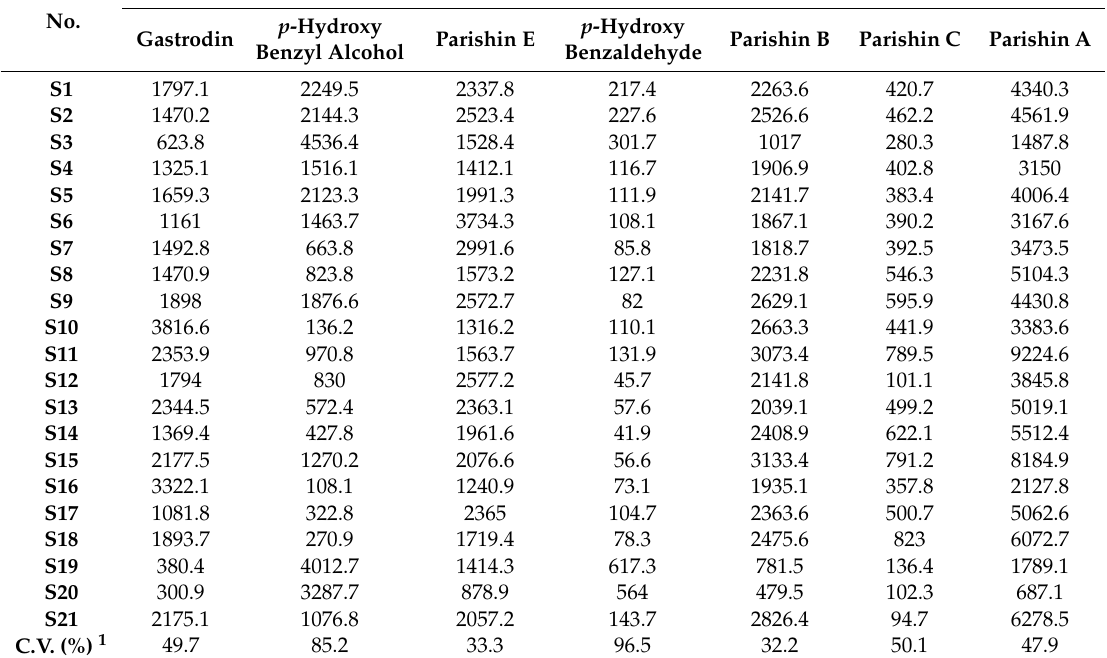
Table 3. The information and peak areas of the seven characteristic peaks in HPLC fingerprints of G. elata tubers.